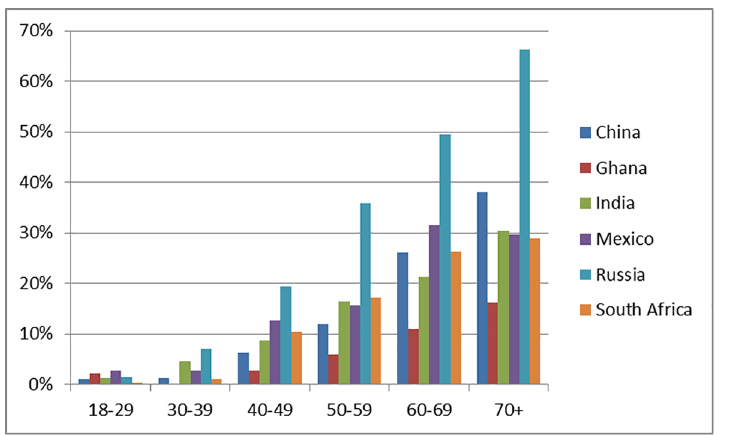
Fig 1. Prevalence of multimorbidity by age groups in SAGE